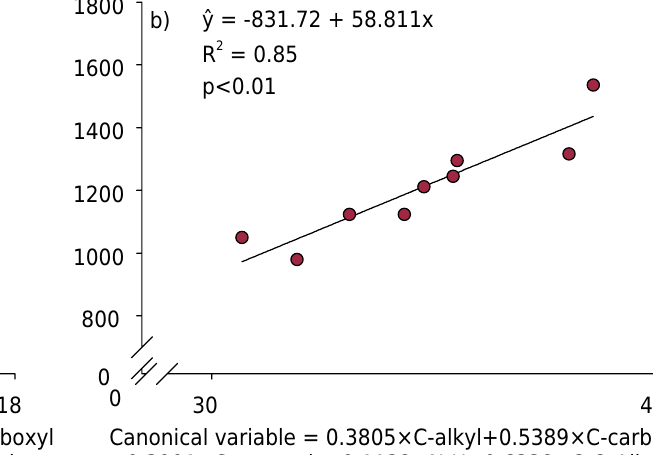
Canonical variable = 0.9751×C-alkyl+0.0459×C-carboxyl +0.1261×C-aromatic-0.1444×N-H+0.0505×C-O-Alkyl